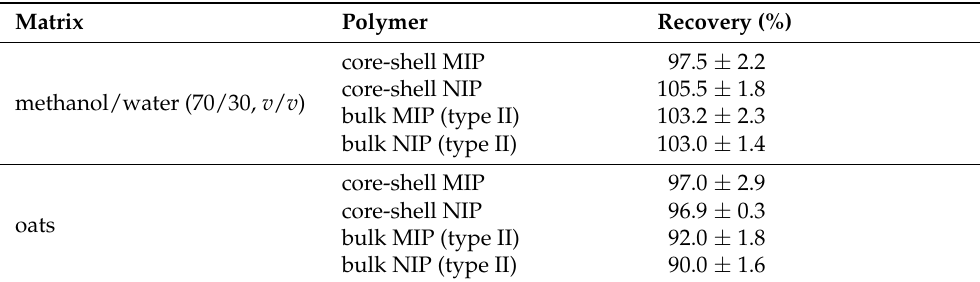
Table 4. CIT (400 ng/mL, 2 mg/kg) recovery by MISPE using RHO-derived core-shell and type II bulk MIP and NIP (mean ± RSD, n = 6).